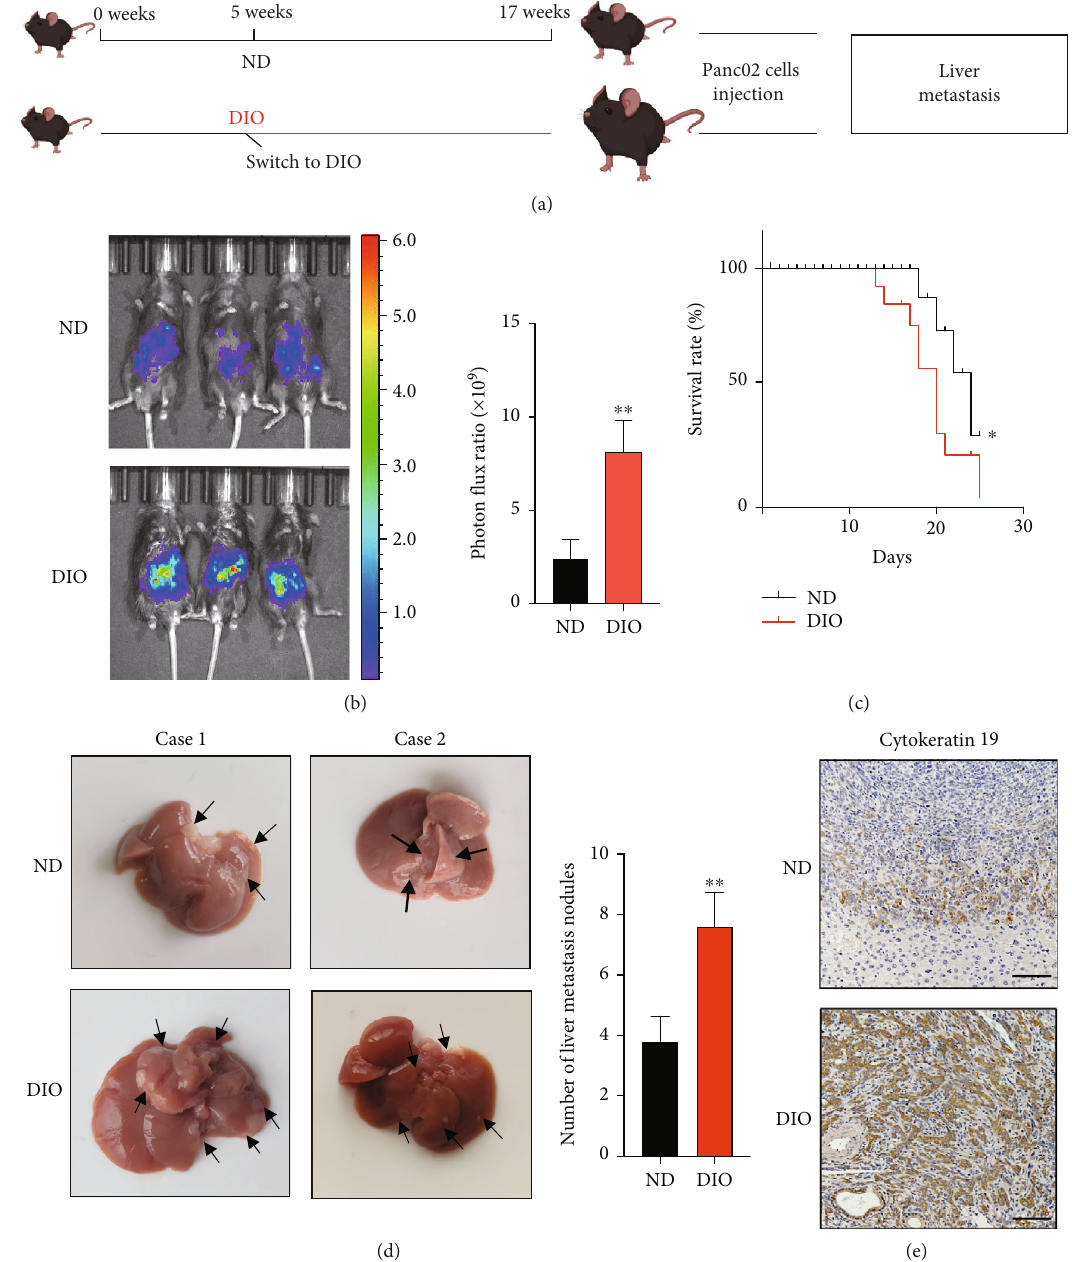
Figure 2: DIO promoted liver metastasis of PDAC. (a) Overview of liver metastasis mouse model. (b) Representative bioluminescence images of ND and DIO mice that injected luciferase-expressing Panc02 cells into spleen, n = 6 /group, ∗∗ P < 0 : 01 . (c) Analysis of overall survival rate of ND and DIO mice, n =6/group. ∗ P < 0 : 05 . (d)Representative images of liver metastasis between ND and DIO. Black arrows, metastatic nodules. Relative number of liver metastasis nodules was quanti fi ed. (e) Representative IHC images of cytokeratin 19, scale bar, 50 μ